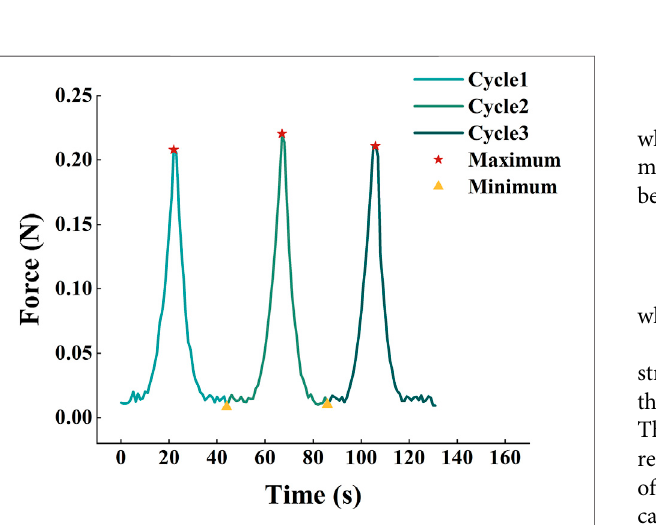
FIGURE3| Divisionofthreeloading/unloadingcycles.Theforceandthe clamp displacement were divided into six segments by the fi ve maximum and minimum force during the loading/unloading